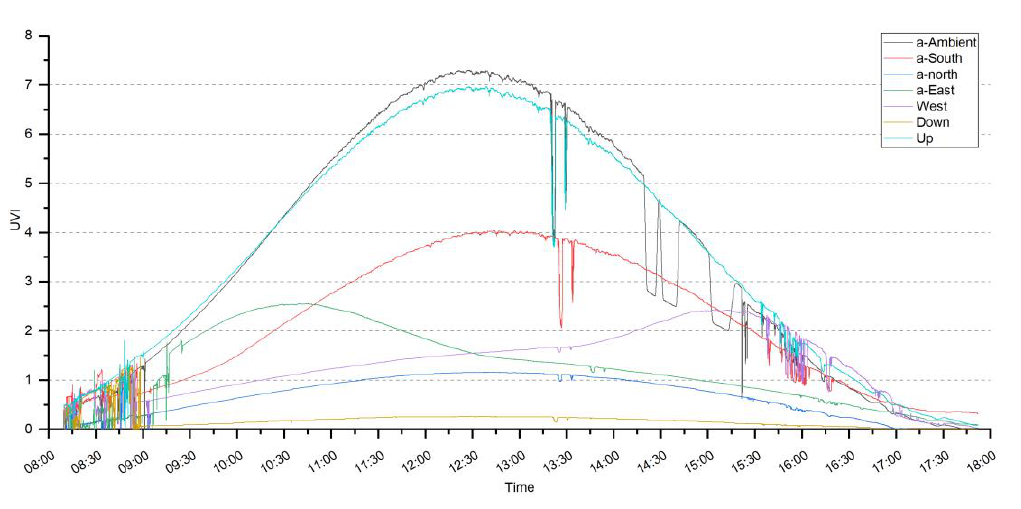
Figure 1. Six-directional ultraviolet radiation (UVR) daily data. Table 4. Descriptive Statistic of six directional UVR values.